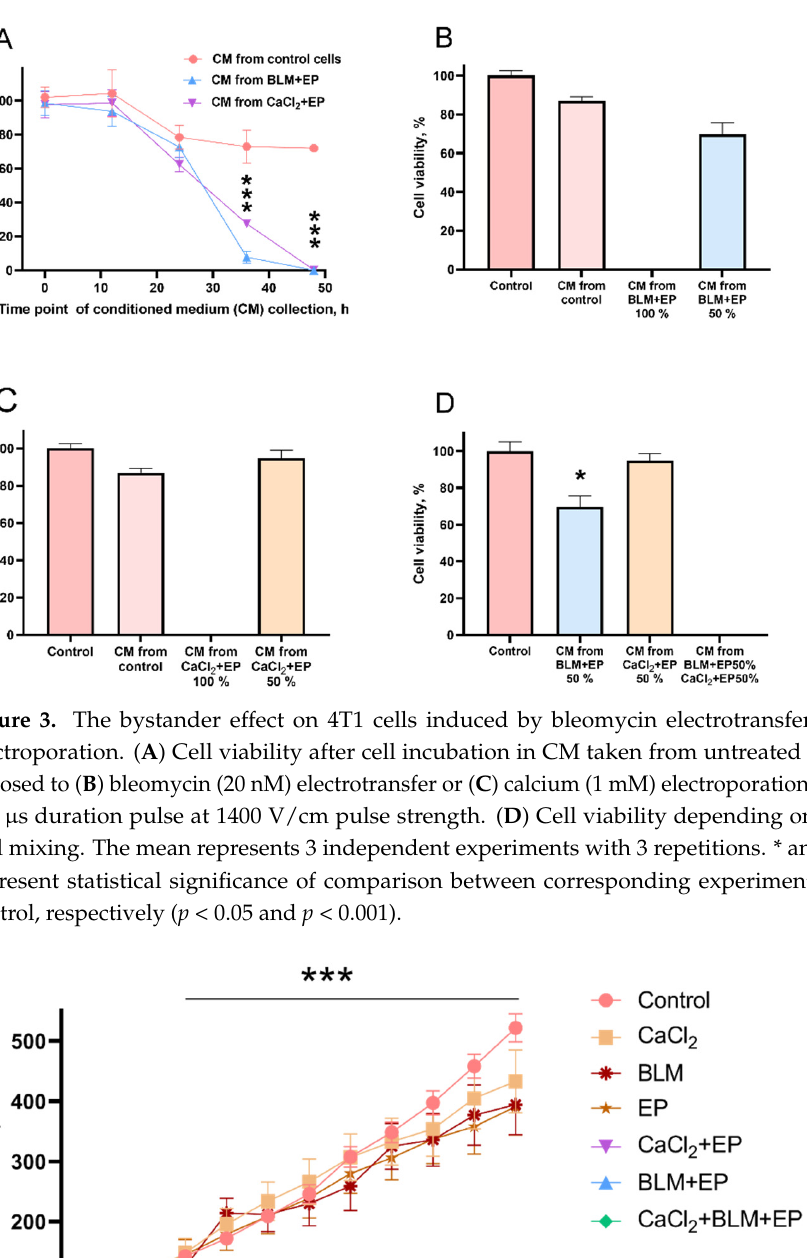
Figure 4. Tumor growth changes in controls and after treatment using bleomycin electrotransfer, calcium electroporation, or the combination of both. Bleomycin solution (200 µ L, 470 µ M) was injected in the mouse tail vein and CaCl 2 solution (half of the tumor volume, 168 mM) was injected directly into the tumor 10 min prior application of electric fields. Eight 1200 V/cm, 100 µ s duration pulses were used for the tumor electroporation. At least 8 mice bearing one tumor each were used for each experiment point. Statistical significance of differences between controls and experimental groups were evaluated using t -test. *** symbols represent statistical significance of p < 0.001 for comparison between control (no treatment) and individual experimental groups (CaCl 2 + EP, BLM + EP, and CaCl 2 + BLM +